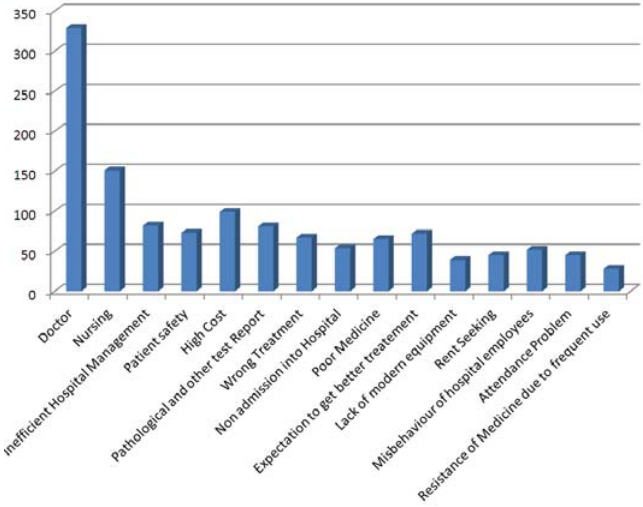
Fig. 5. Reasons for inefficiencies in Bangladesh healthcare management Source: developed for this research. Table 4. Potentialities for India to develop further